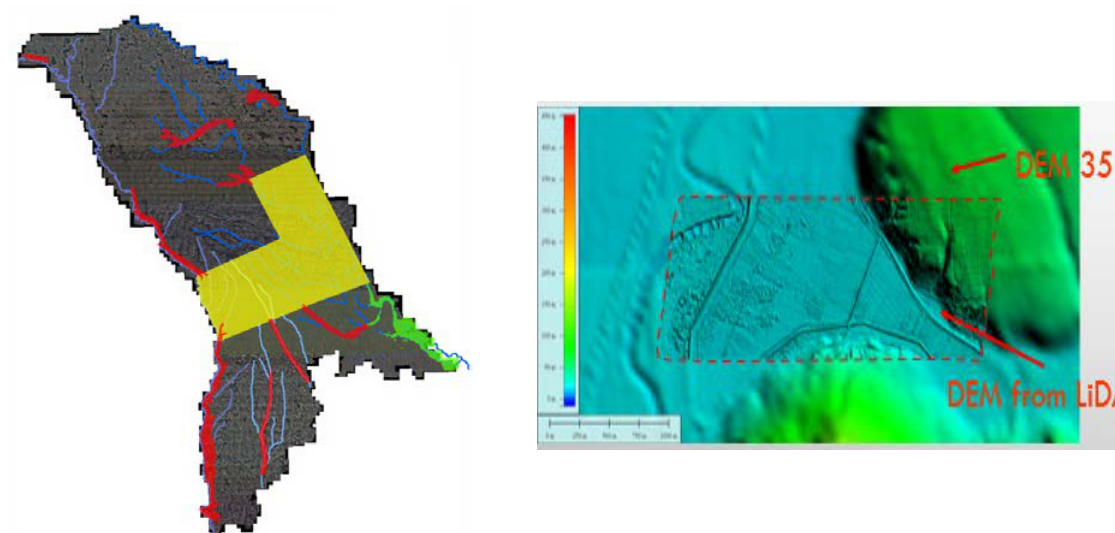
Figure 3. Data collections: Yellow - existing LiDAR survey of the central part of Moldova (2011, ALRC); Red - new LiDAR survey; Green - photogrammetric data